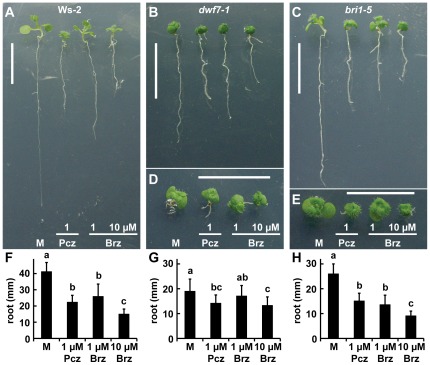
Sensitivity of Arabidopsis wild type, BR biosynthetic mutant dwf7-1, and signaling mutant bri1-5 to Pcz and Brz.(A–C) Seedlings of (A) Ws-2, (B) the BR biosynthetic mutant dwf7-1 (Ws-2), and (C) the BR signaling mutant bri1-5 (Ws-2) grown on ½ MS media with either 1 µM Pcz or Brz or 10 µM Brz. (D–E) Close-up of the shoot apices harboring cotyledons and the first pair of true leaves of (D) dwf7-1 and (E) bri1-5. (F–H) Average root lengths of (F) Ws-2, (G) dwf7-1 and (H) bri1-5 measured at the end of treatments (n>10). (F–H) Error bars represent standard deviation and lowercase letters indicate significant differences among treatments determined by “Post-hoc” test (p<0.05). Scale bar (A–E) 1 cm.